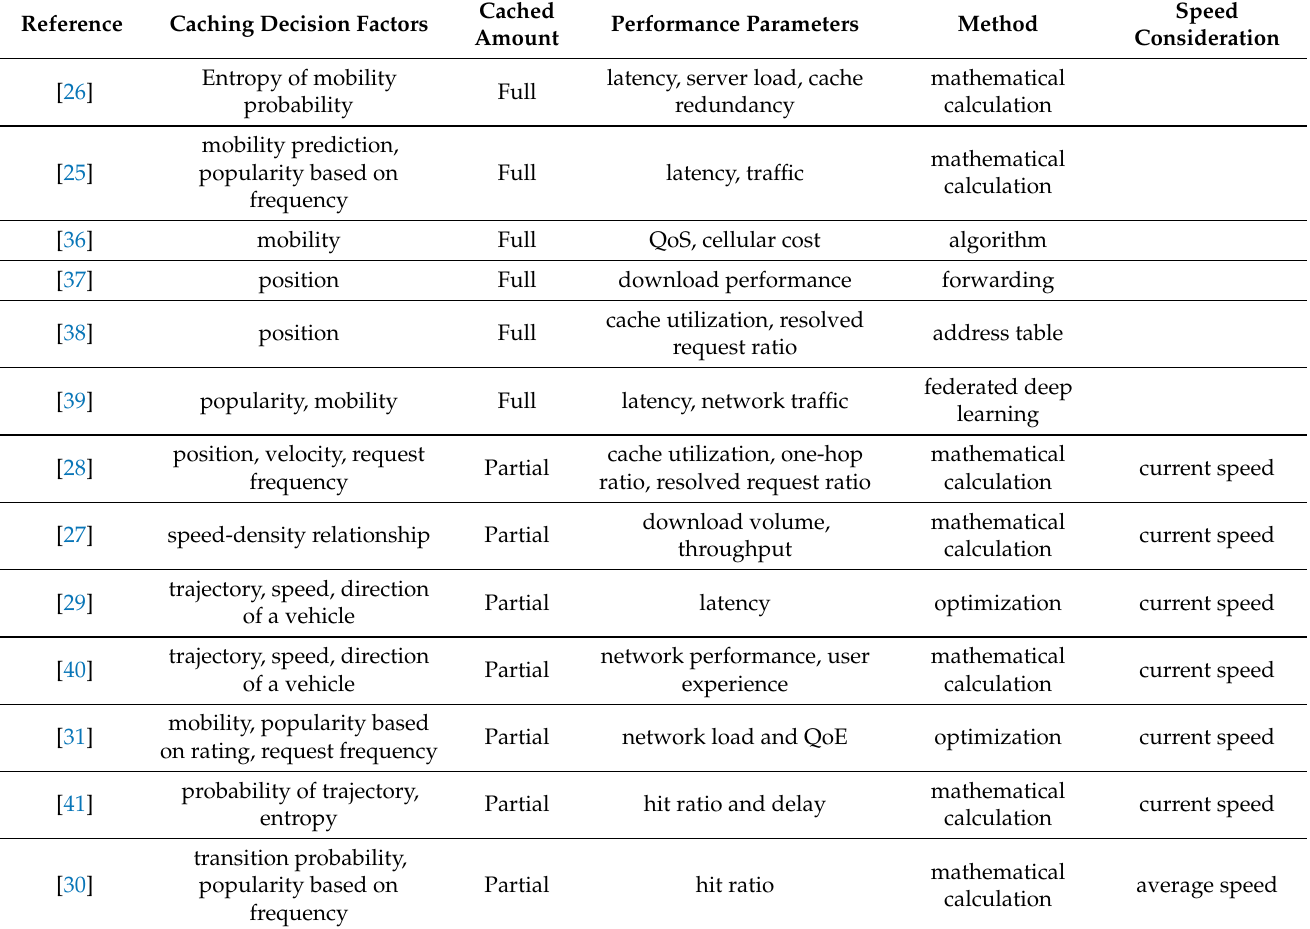
Table 2. The summary of the related works on precaching in